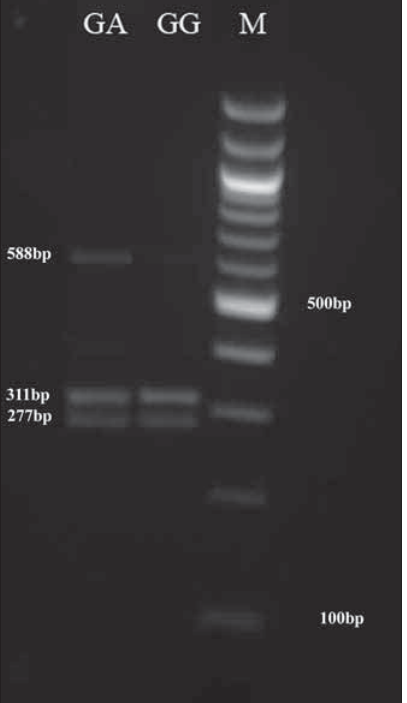
Figure-1: Polymerase chain reaction-restriction fragment length polymorphisms of mannose-binding lectins gene fragment using Apa I RE. (Lane 1: GA genotype, Lane 2: GG genotype, Lane 3: 100 bp DNA